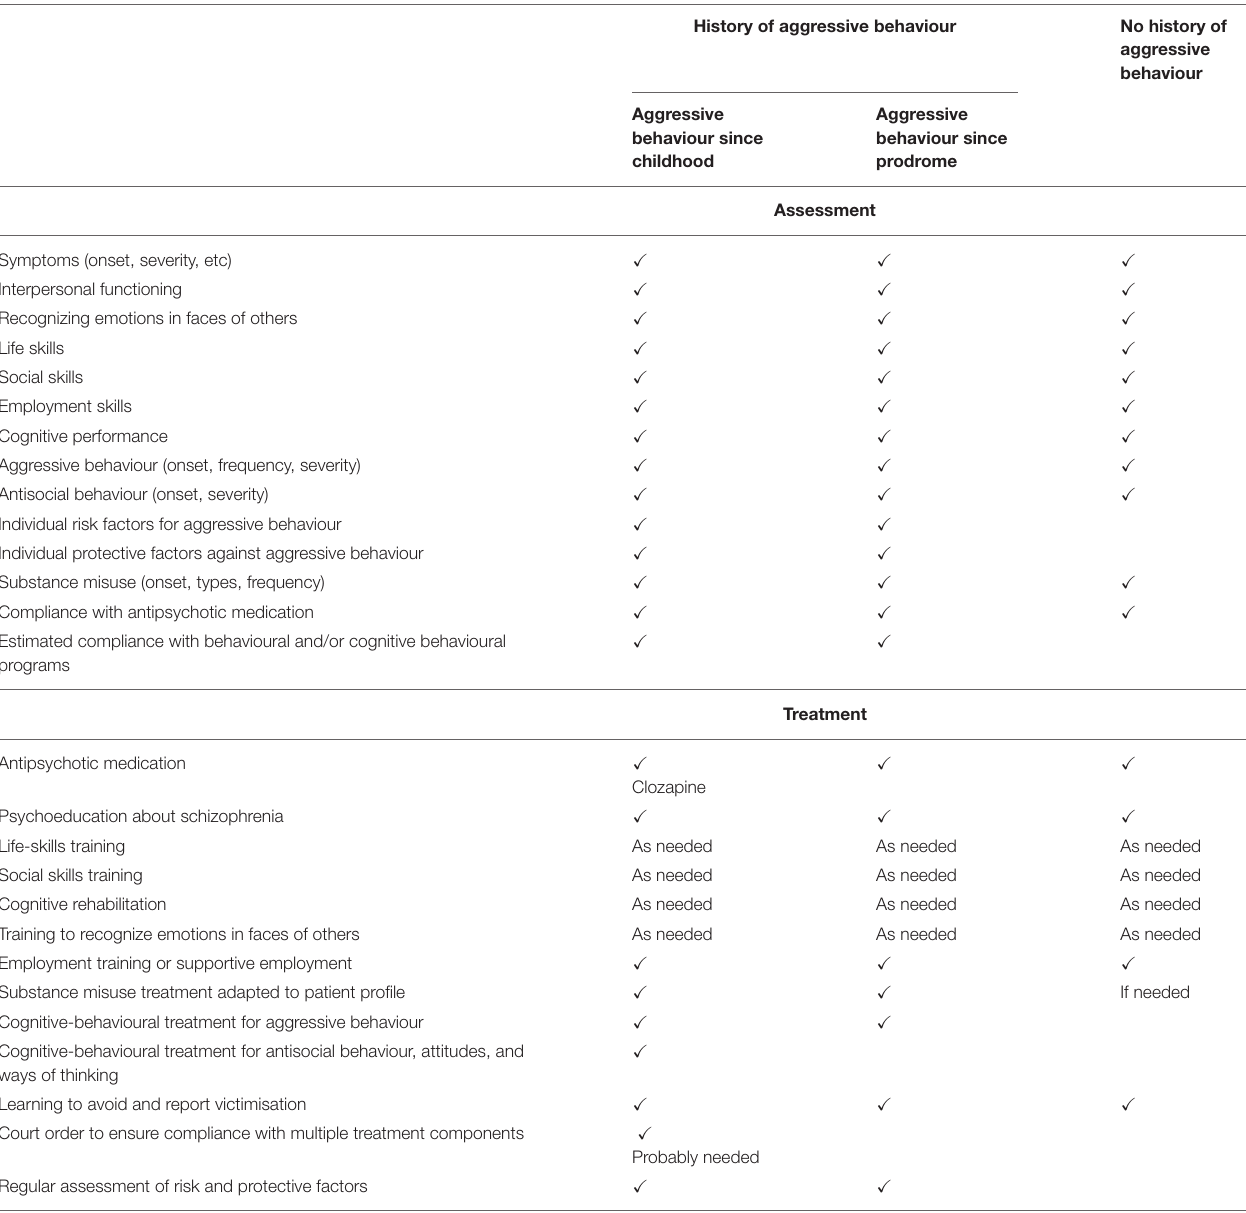
TABLE 1 | Assessment and treatment of schizophrenia, aggressive and antisocial behaviour at first-episode of psychosis.